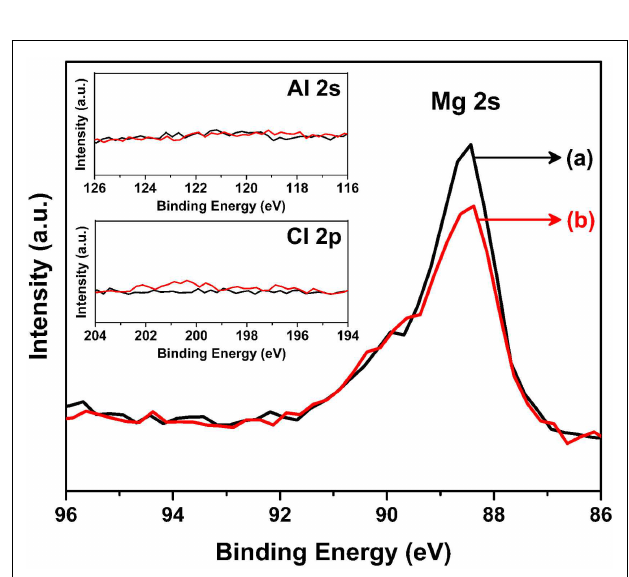
FIGURE 7 | Mg 2s XPS spectra for sputtered Mg metal (a) before and (b) after the soaking experiment shown in Figure 6 . Inset figure shows the spectra of (top) Al 2s and (bottom) Cl 2p for the same sputtered